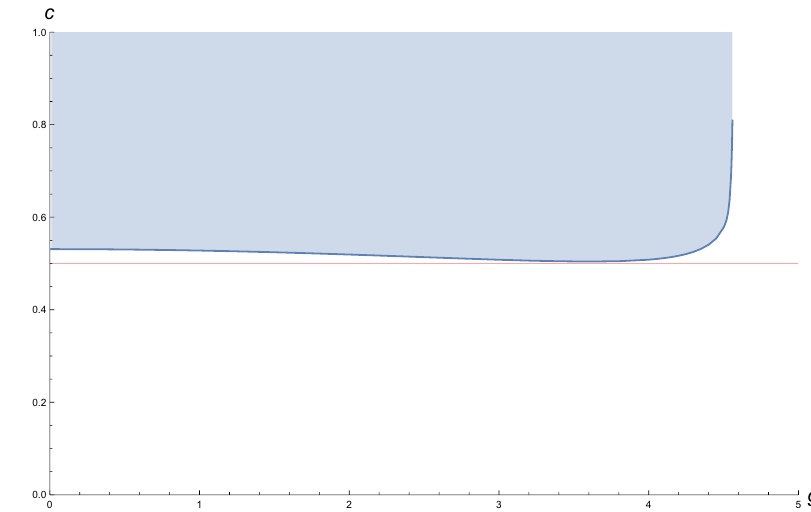
Figure 3 . Lower bound on the UV central charge as a function of the cubic coupling g between particles of mass m 1 = 1, m 1 = 1 and m 2 = p 3. The allowed region is depicted in blue. The bound extends up to g = 4 : 55901 which is a critical value for which the optimization problem is feasible. The bound was obtained with N max = 50. The red horizontal line at c = 1 = 2 is added for convenience.